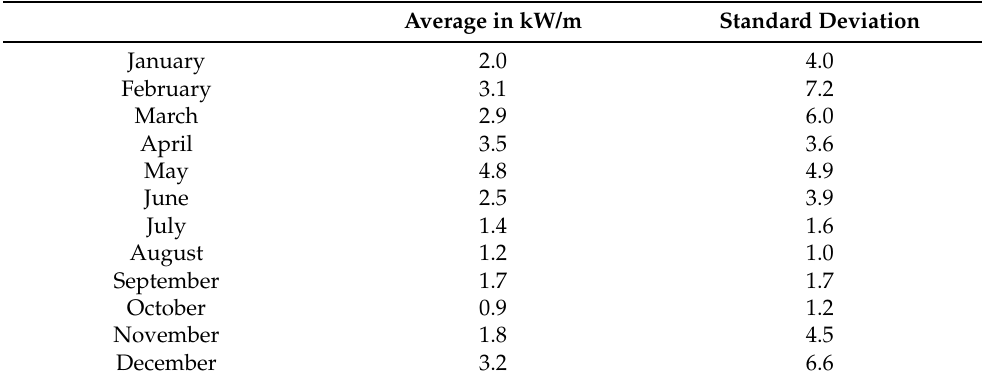
Table 2. Energy monthly averages and standard deviations calculated on 56 nodes over a total of 490,650